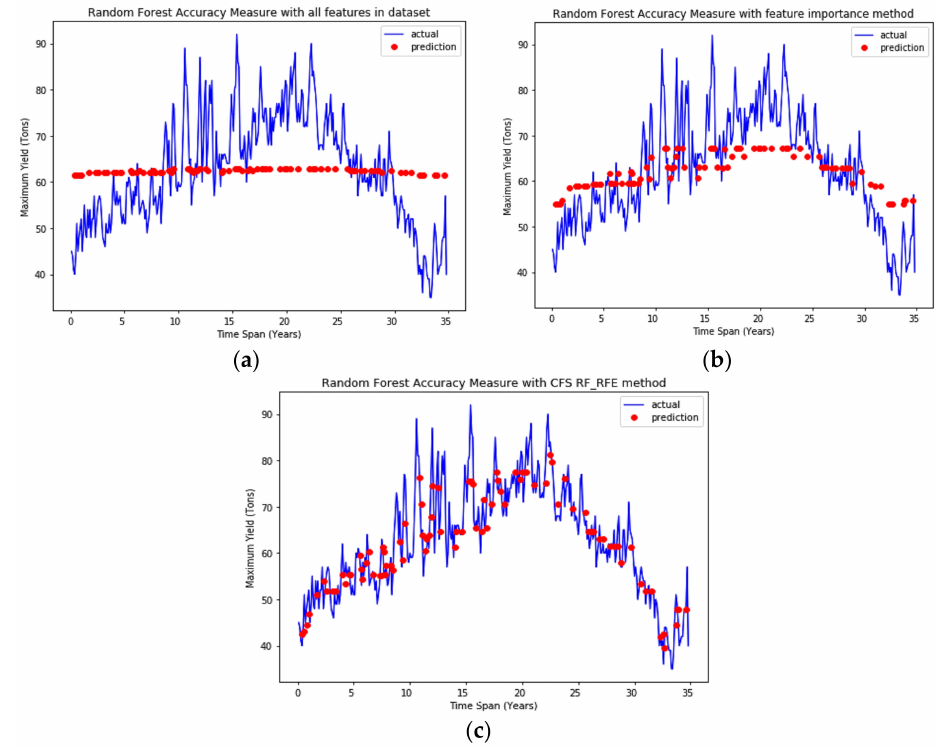
Figure 6. Random forest model accuracy measure using: ( a ) proposed CFS RF-RFE feature selection method, ( b ) algorithm in-built feature importance method, ( c ) all the features in the